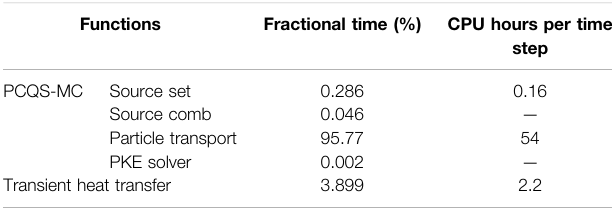
TABLE 2 | Computation burden for major functions. TABLE 3 | Critical boron concentrations from different conditions and codes.